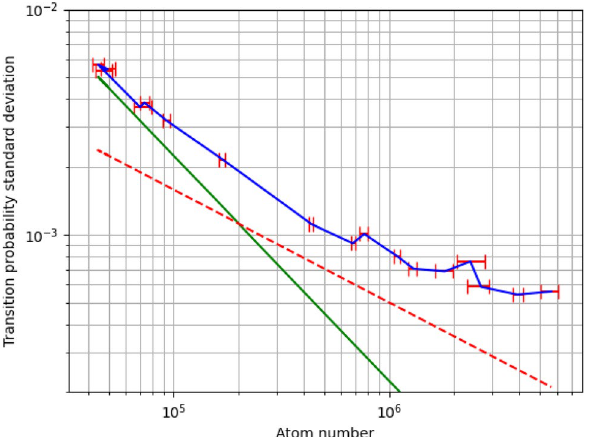
Figure 10. Standard deviation of the measured transition probability, as a function of the number of atoms detected. The green line corresponds to 1/ N the noise limit associated to the electronic noise from the photodiodes shown in Fig. 6. The red dashed line corresponds to the quantum projection noise proportionnal to 1 / √ N